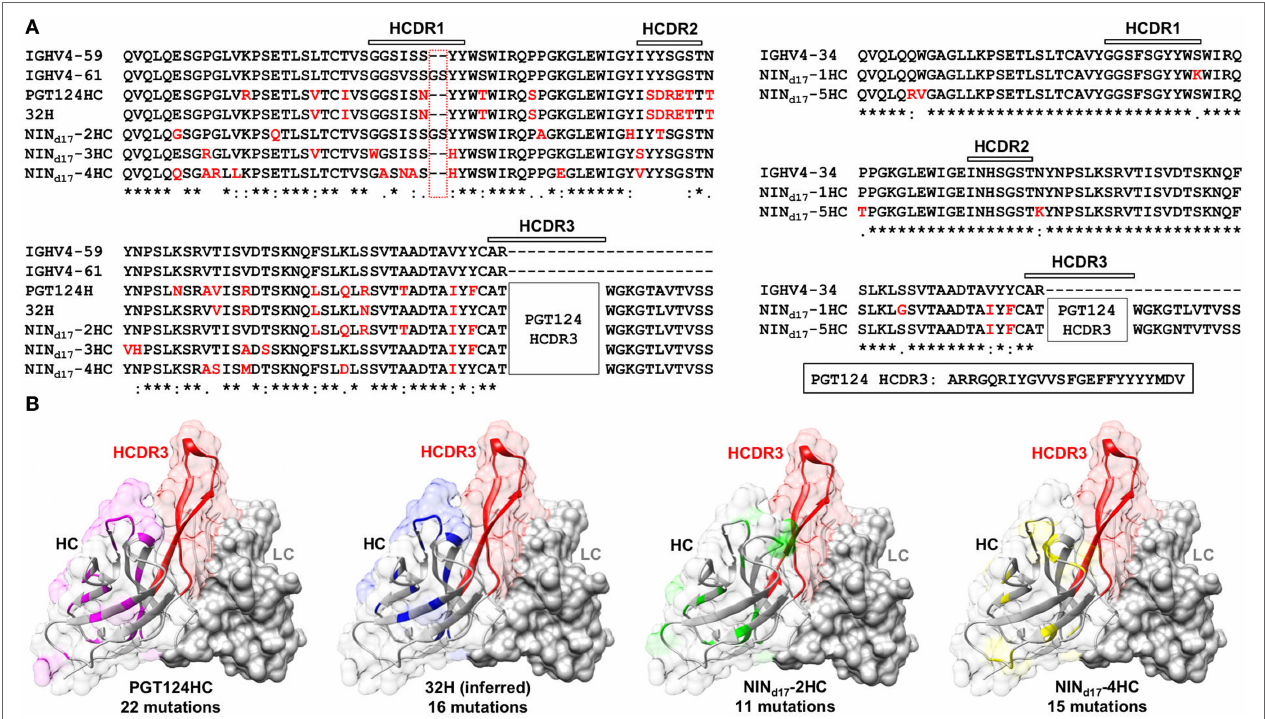
FigUre 8 | Sequence and structure analyses of the PGT124 intermediates identified from a focused donor-17 single-chain variable fragment (scFv) library. (a) Sequence alignment of NIN d17 -2, -3, and -4 with two HC germline genes (IgHV4-59 and IgHV4-61), PGT124 HC, and inferred 32H (18) (left), and sequence alignment of NIN d17 -1 and -5 with the germline gene IgHV4-34 (right). The three HCDR regions are marked above the sequences, with the mutations with respect to IgHV4-59 (left) and IgHV3-34 (right) colored in red. As the HCDR3 region in all NIN d17 sequences is identical to that of WT PGT124, it is highlighted separately and not shown in the sequence alignment. (B) Structural mapping of HC mutations onto the antibody surface for PGT124, inferred intermediate 32H, NIN d17 -2, and NIN d17 -4. The structures of antibody variable domains were modeled using the PGT124 structure as a template (PDB ID: 4R2G), with HCs shown as ribbons in transparent molecular surface and LCs as solid gray molecular surface. The HCDR3 loop is colored in red in all models, whereas HC mutations are colored in pink for PGT124, blue for 32H, green for NIN d17 -2, and yellow for NIN d17 -4. The number of amino acid mutations with respect to the germline gene (IgHV4-59) is indicated under the structural